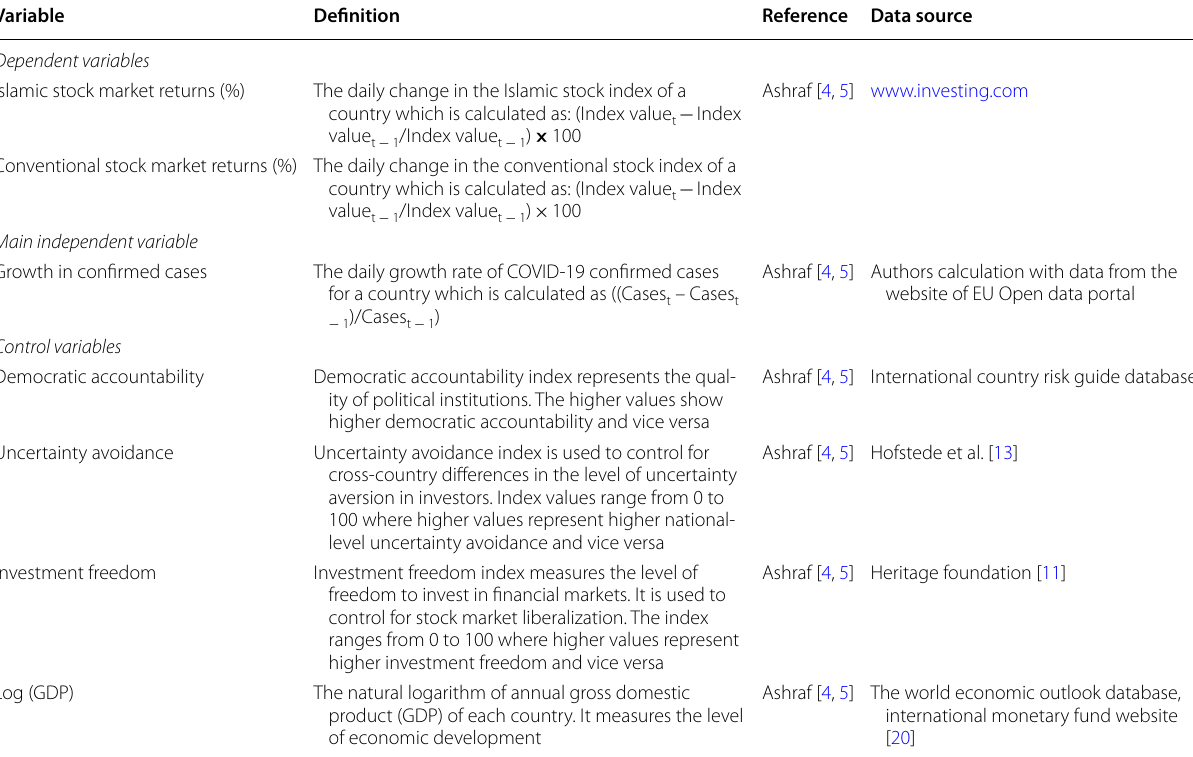
Table 7 Variable definitions and the data